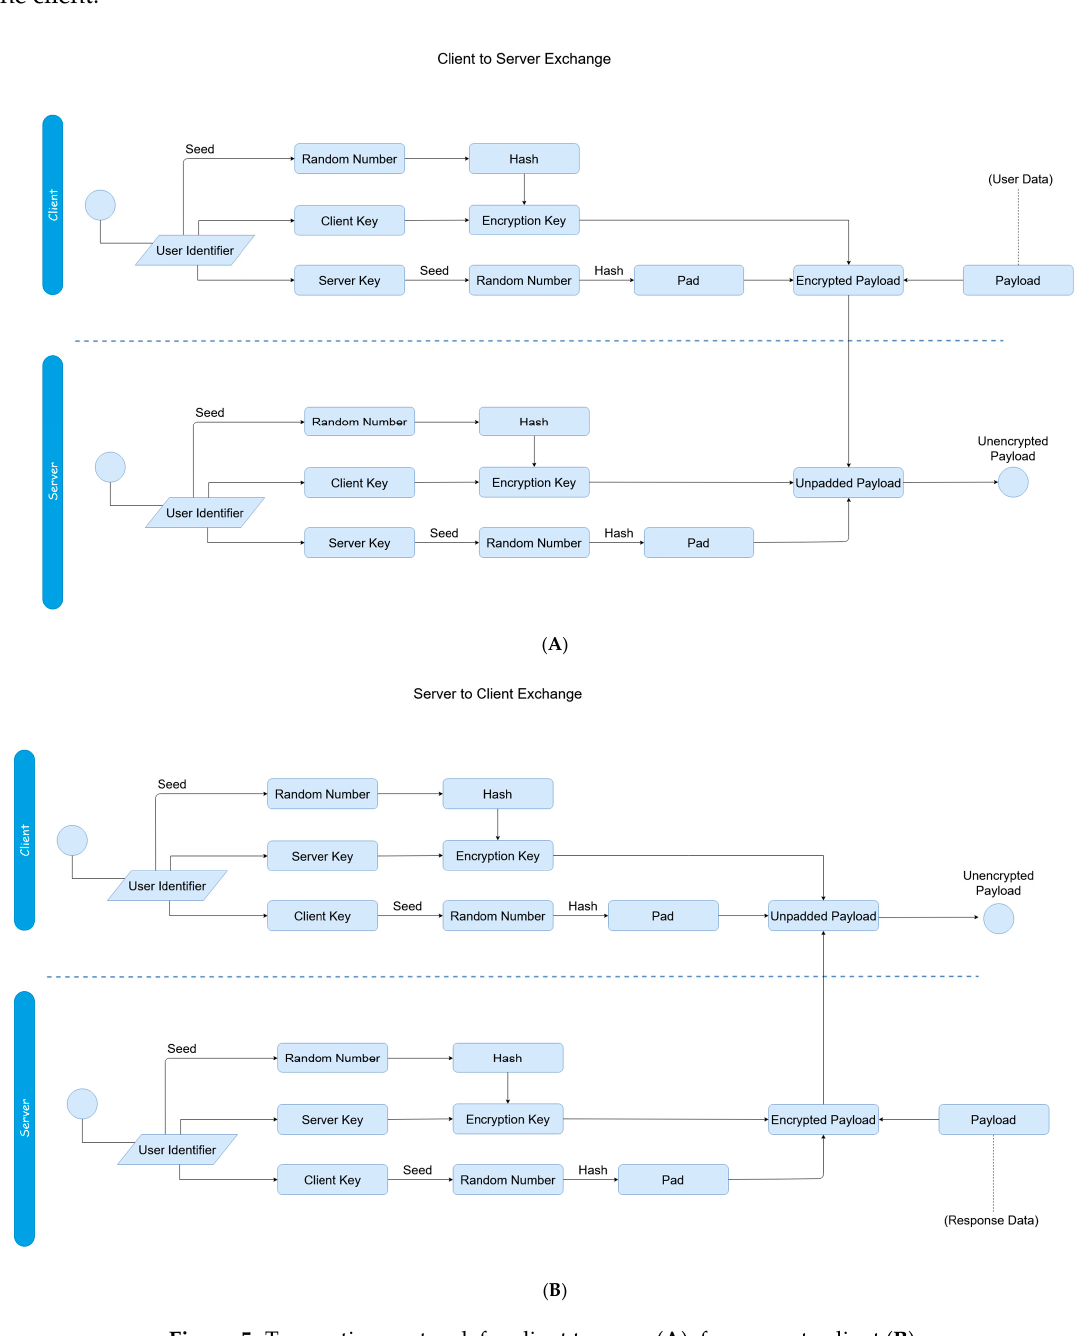
Figure 5. Transaction protocol, for client to serve ( A ); for server to client ( B ).